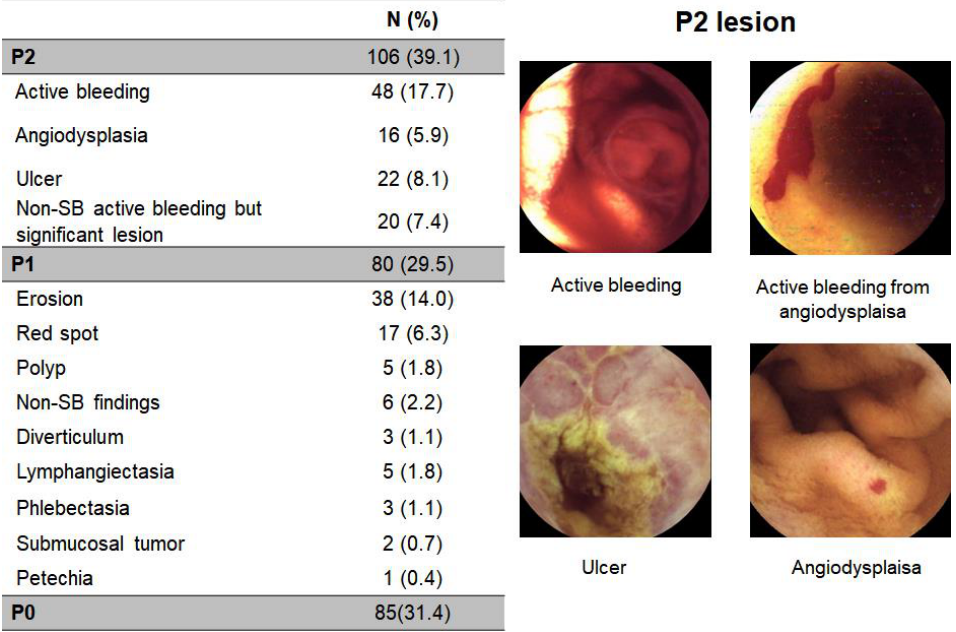
Figure 2. Video capsule endoscopy findings. SB, small bowel.